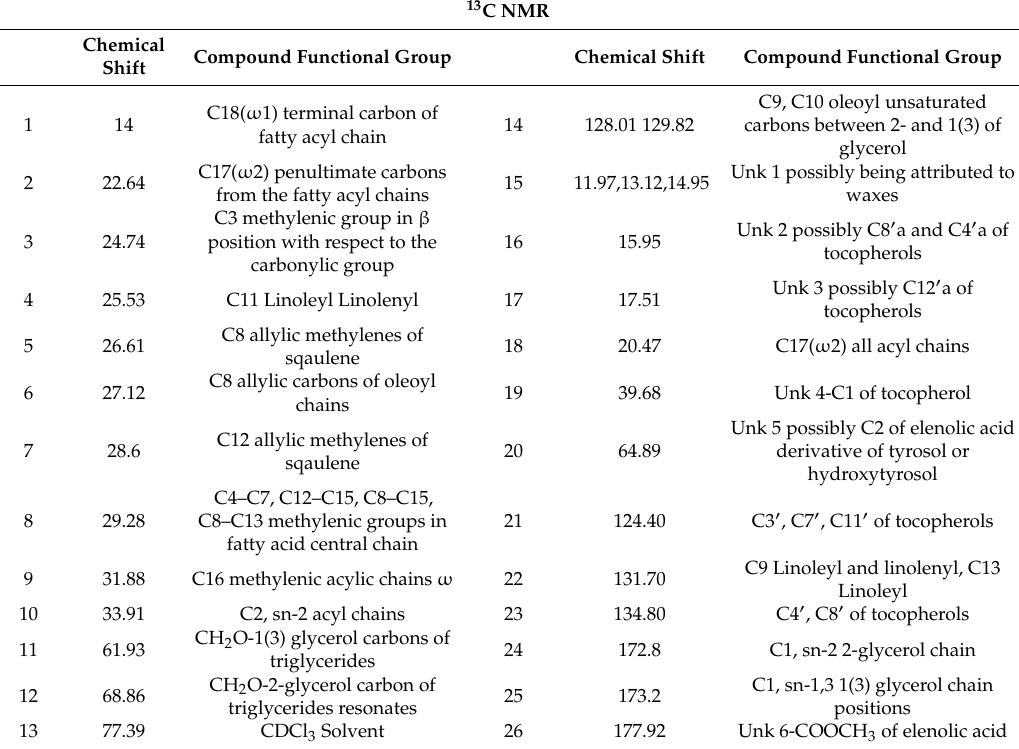
Table 2. Chemical shifts and the corresponding chemical functional group observed for 13 C